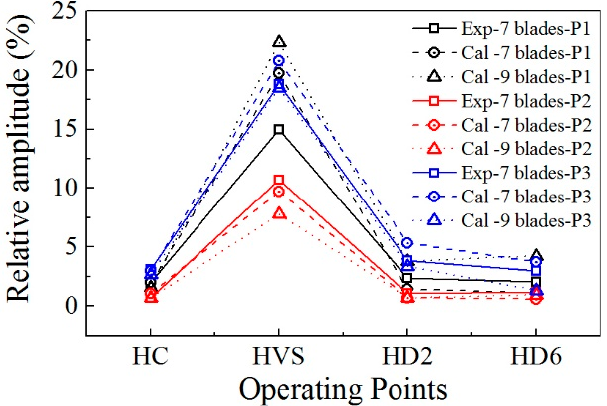
Figure 19. Comparison of relative amplitude with 9 blades and 7 blades at P1, P2 and P3 operating points.